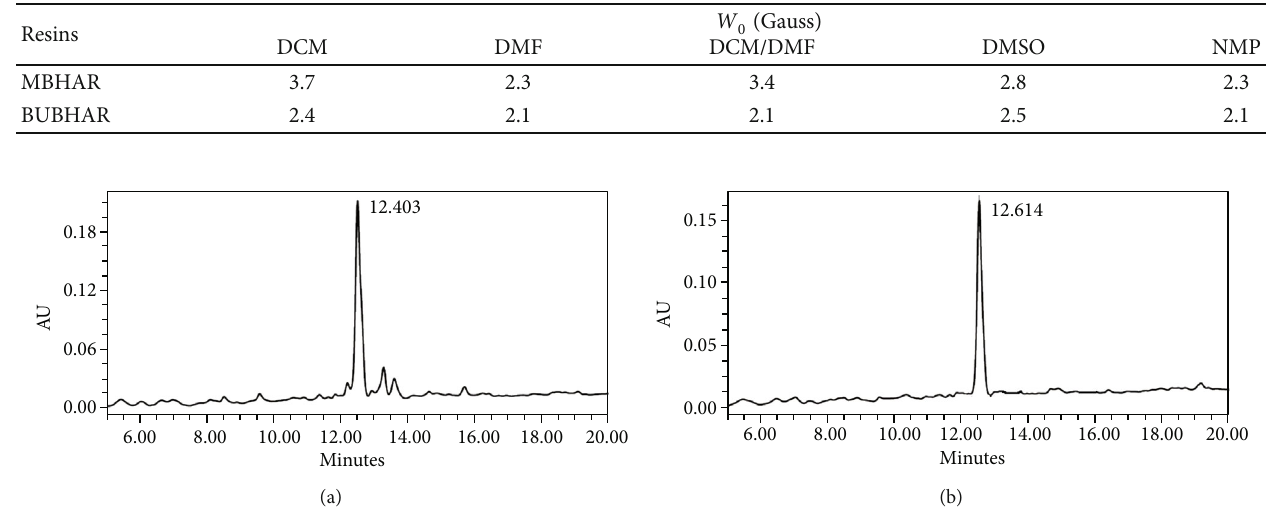
Figure 3: High-performance liquid chromatography (HPLC) pro fi les of crude Gln-Asn-Cys-Pro-(D-Arg)-Gly peptide amide synthesized in MBHAR (a) and in BUBHAR